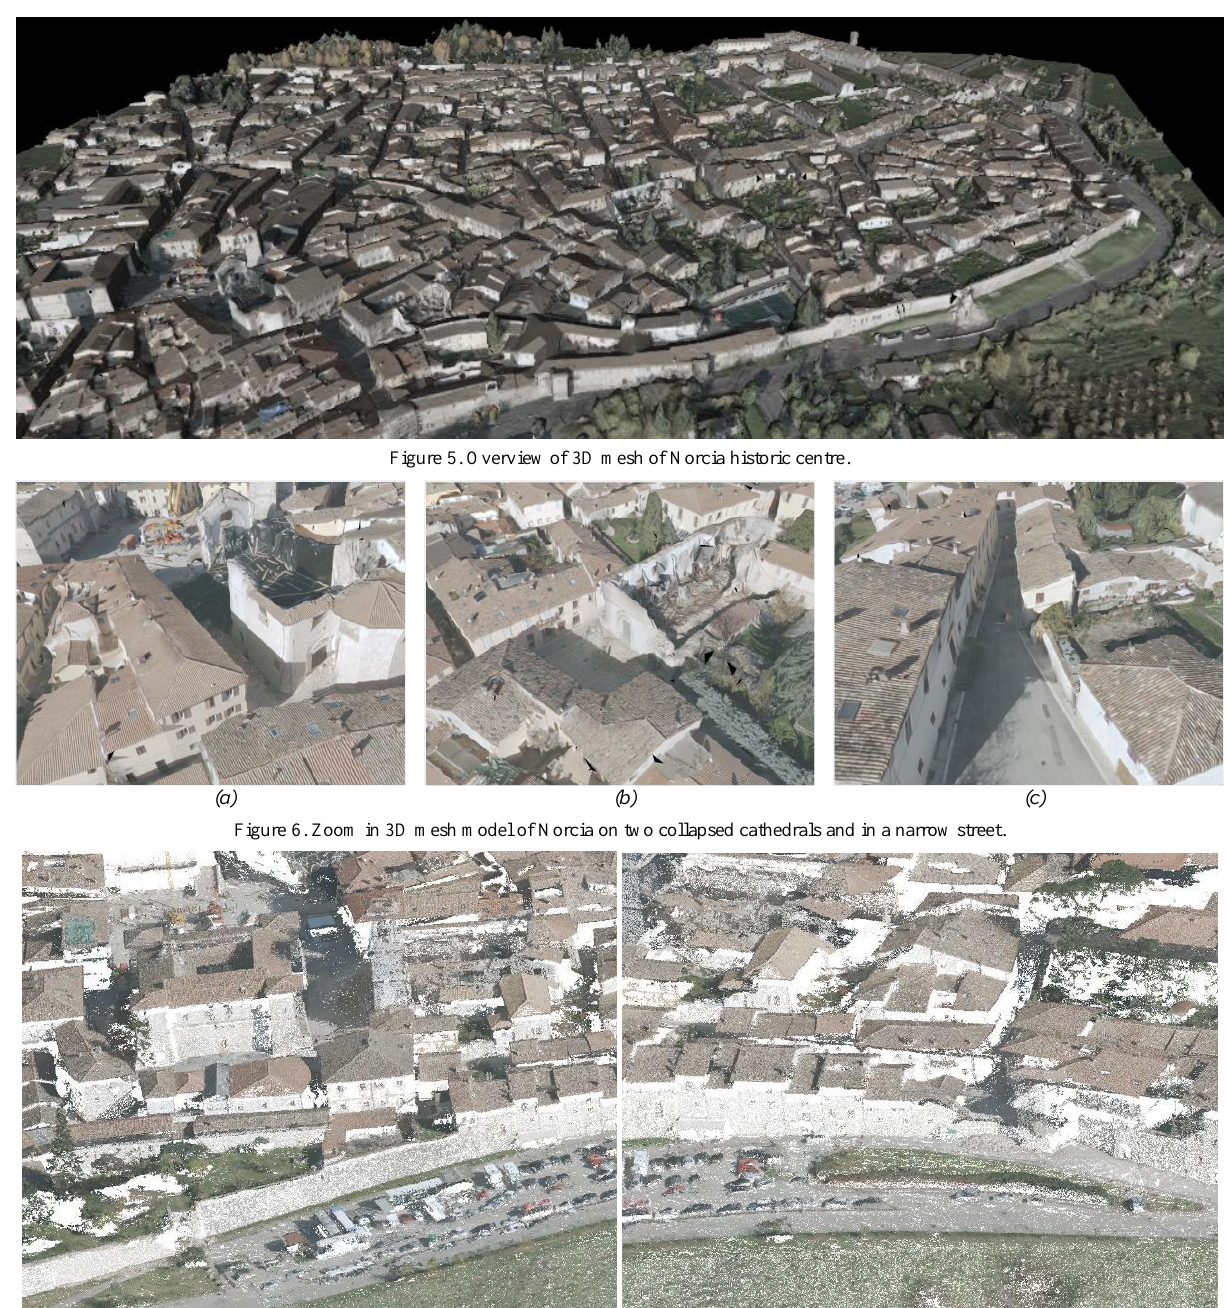
Figure 7. 3D point cloud of Norcia with RGB